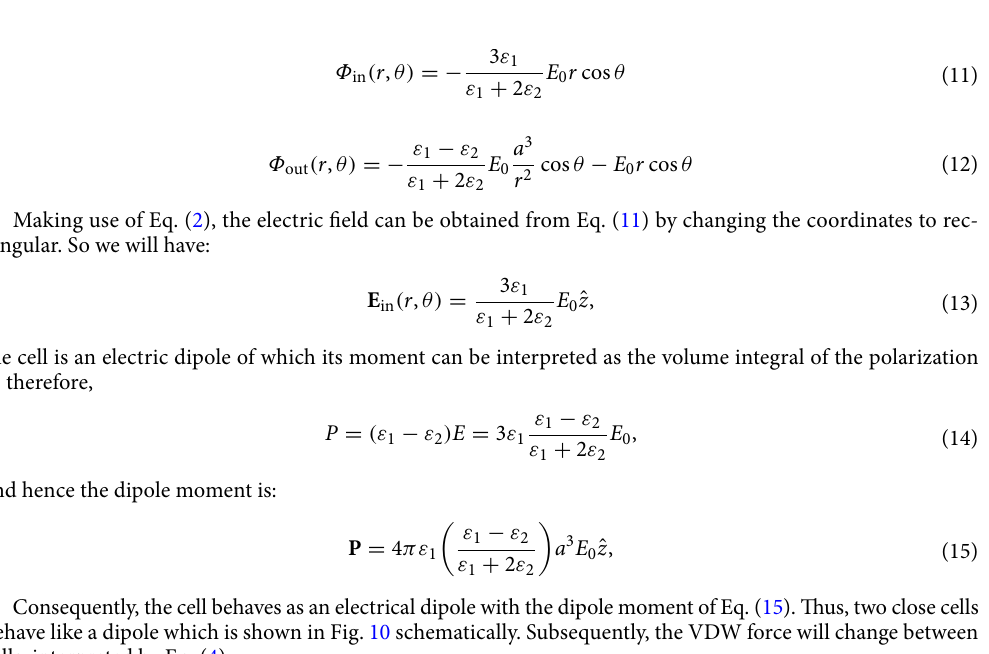
Figure 14. The schematic of cells, their distance, media and their